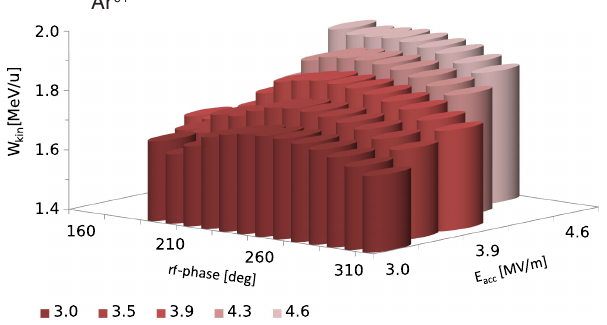
FIG. 10. 3D scan of Ar 9 þ -beam energy versus accelerating gradient and rf